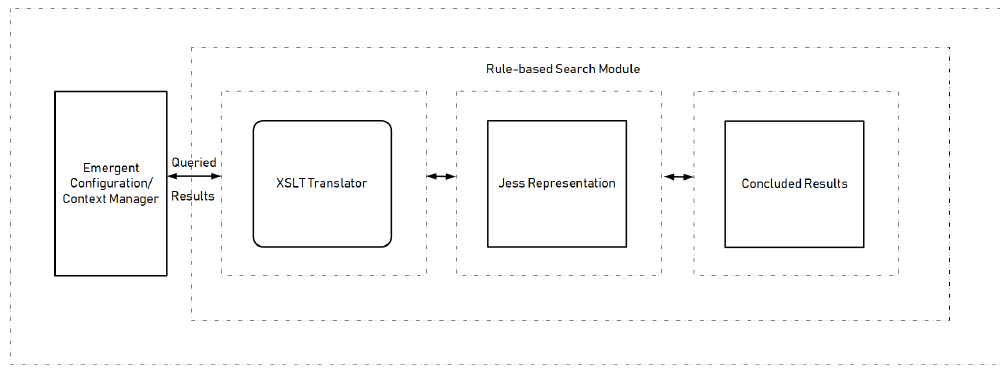
Figure 9. System architecture of a Rule base